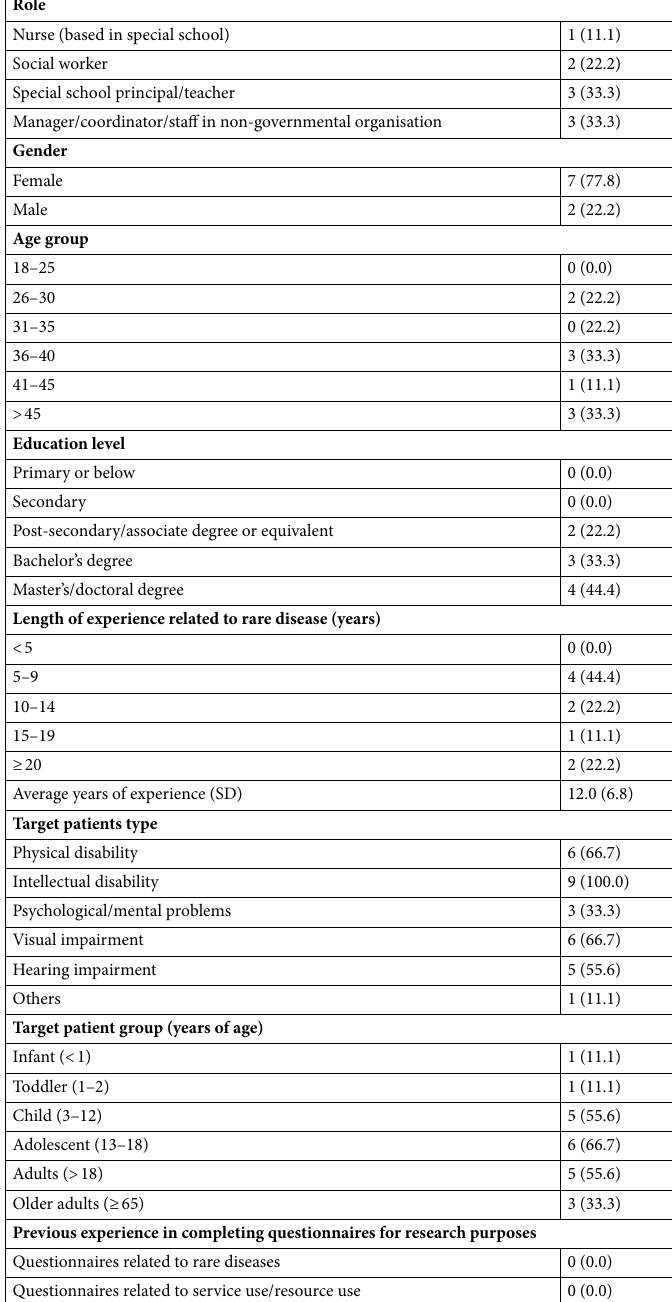
Table 2. Characteristics of the nine professional participants in the second focus group meeting. SD Standard